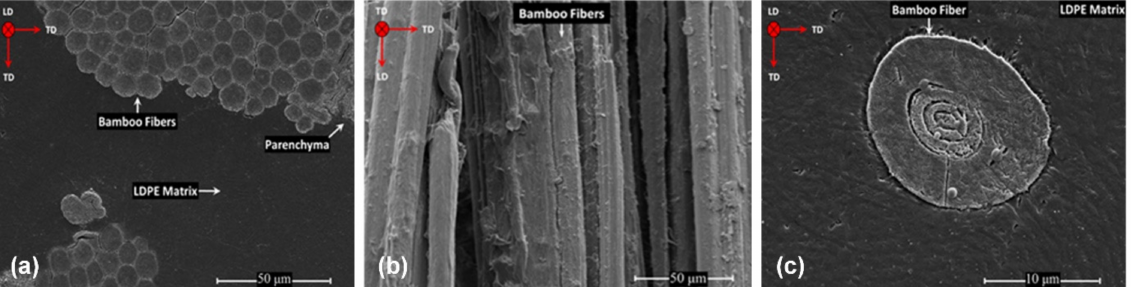
Figure 3. ( a ) Representative SEM image displaying the morphology of the LDPE-BFs AL composite sheet, ( b ) longitudinal view of the bamboo bundles and ( c ) high-magnification image showing the interfacial area of an individual BFs AL with the LDPE matrix in the LDPE-BFs AL composite sheet.